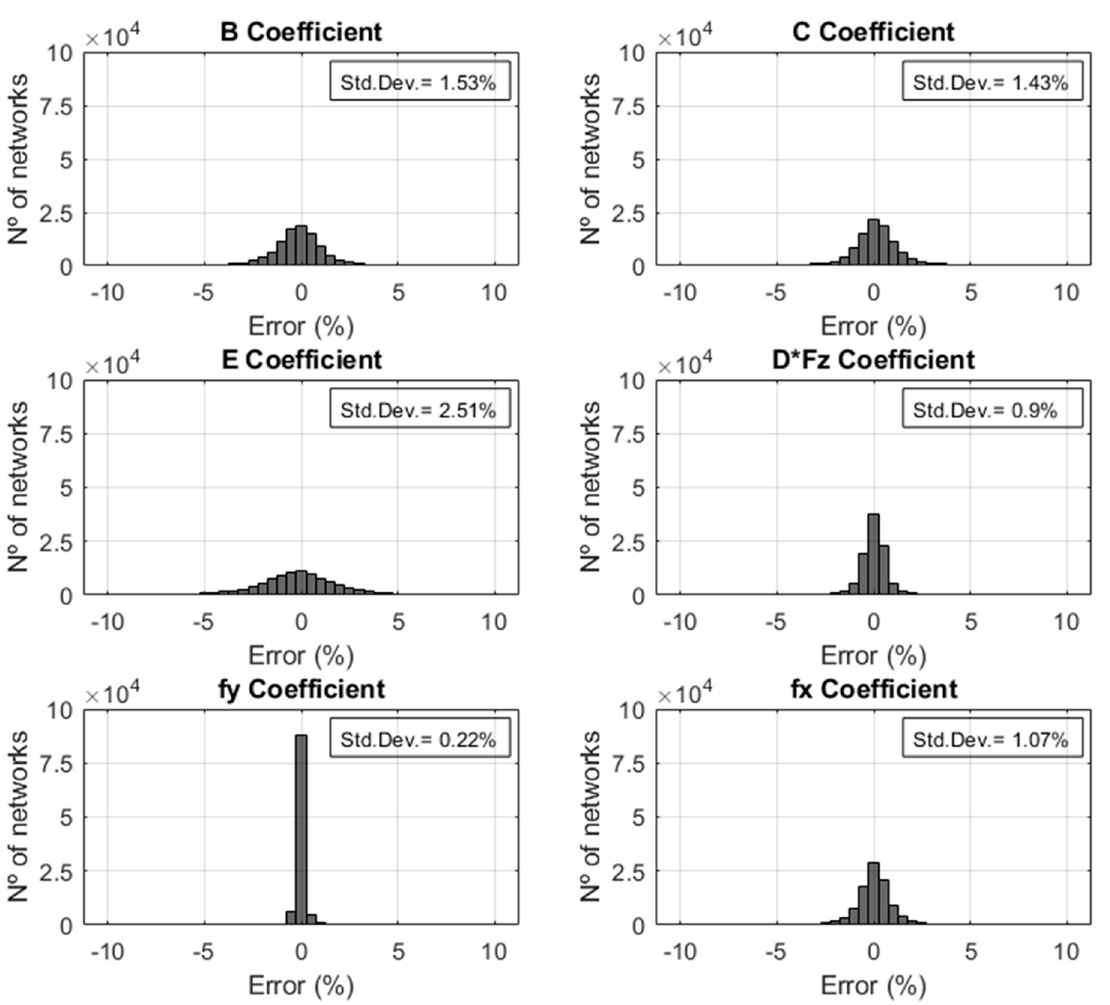
Figure 11. Example of fx parameter and ANN error. Table 2. Range of values for MF model